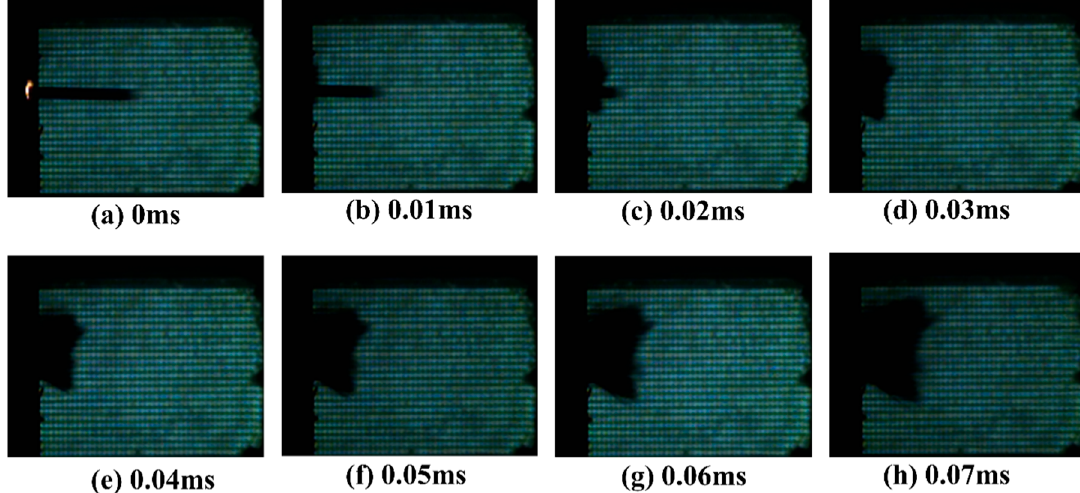
Figure 4. Typical photographs of the long-rod projectile penetrating a concrete target at 2117 m/s.